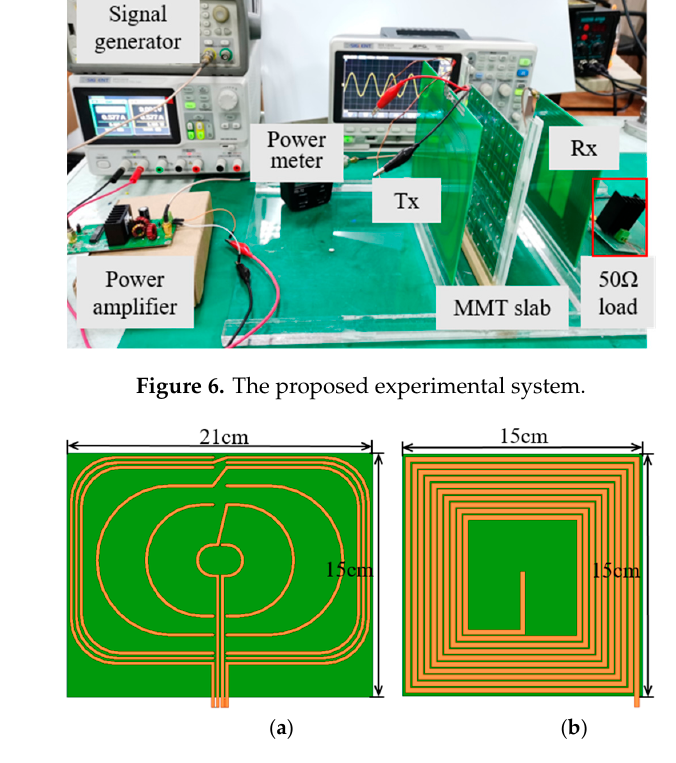
Figure 7. ( a ) The transmitting coil, ( b ) the receiving coil.